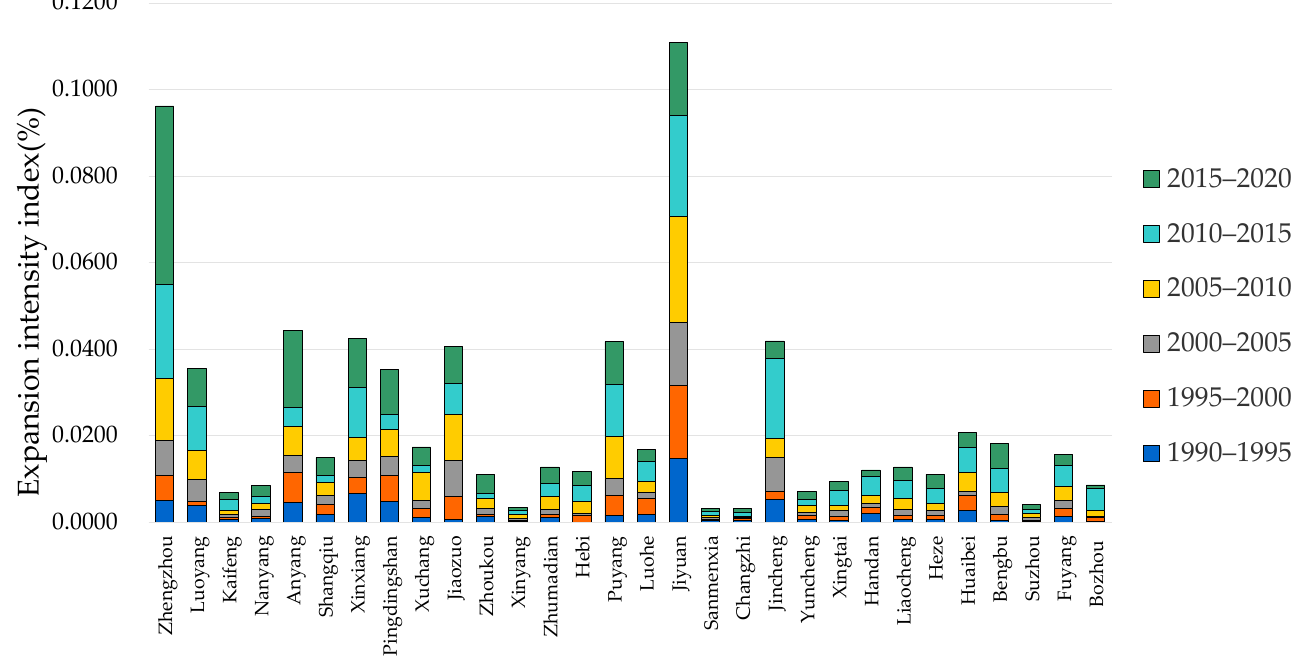
Figure 3. Expansion intensity of different cities in different periods.